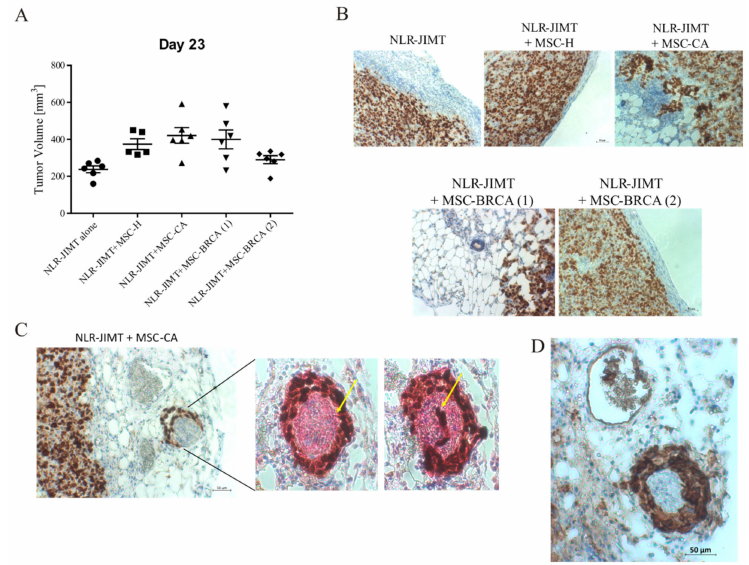
Figure 9. Pro-tumorigenic e ff ect of MSC-CA in orthotopic mouse model. ( A ) Mixture of 5 × 10 5 NLR-JIMT cells and 2.5 × 10 5 MSCs in 100 µ L serum-free DMEM diluted 1:1 with ECM